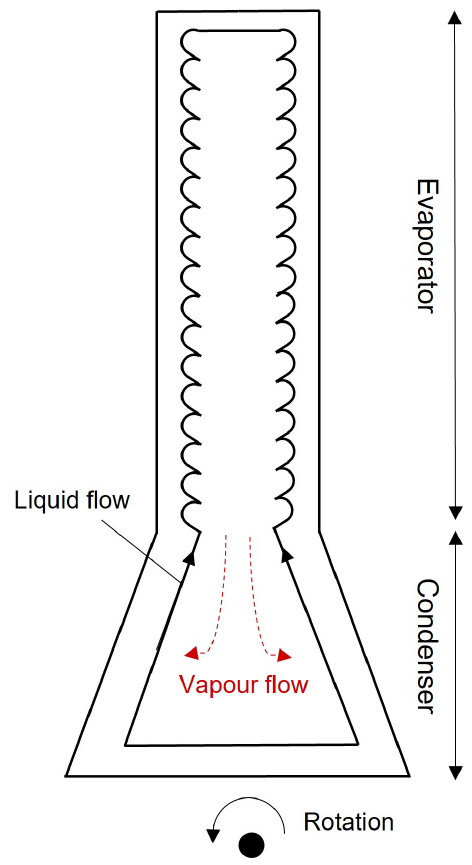
Figure 3. Schematic illustration of the RRHP designed by Townsend et al. [38].